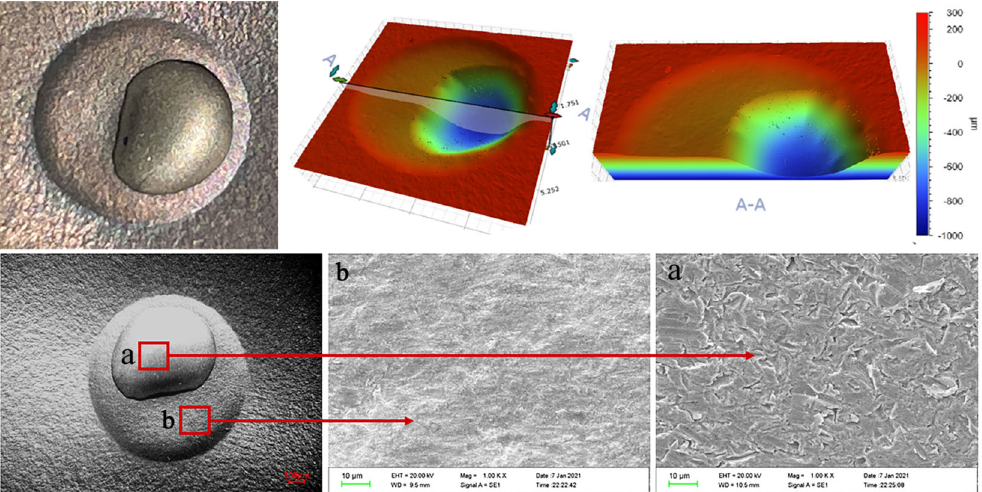
Figure 8. Erosion topography of grit blasting coating. (a) morphology of substrate. (b) morphology of coating erosion.